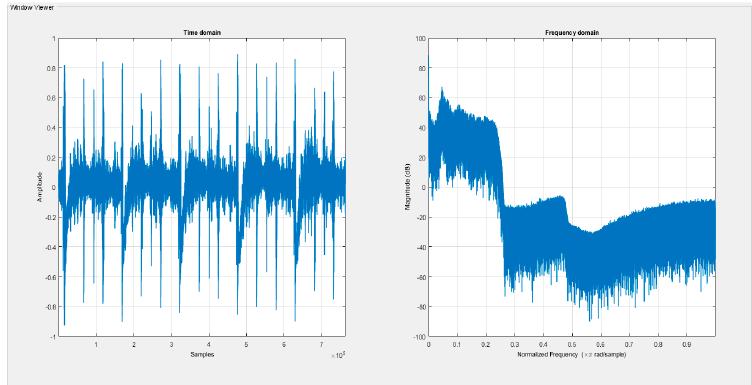
Figure 13. Analysis of the signal derived from working mud pump with a damaged valve (no external symptoms could be observed by persons responsible for the pump operation). The amplitude-time signal ( left ) and magnitude (dB) as a function of frequency ( right ).